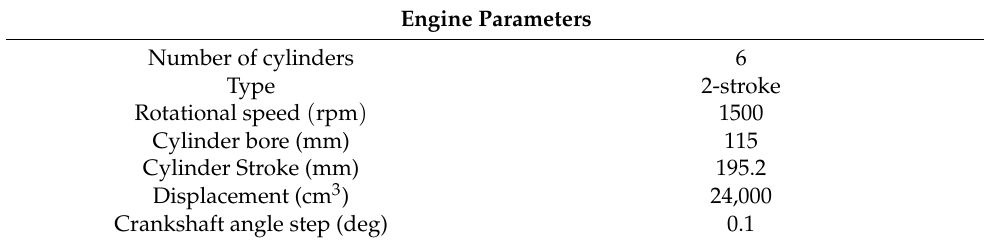
Table 2. The operating parameters of the 6-cylinder, 2-stroke engine.